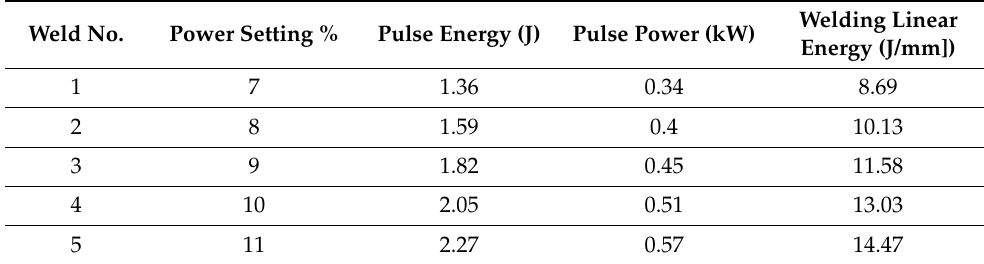
Table 2. List of welding parameters accepted after visual testing.